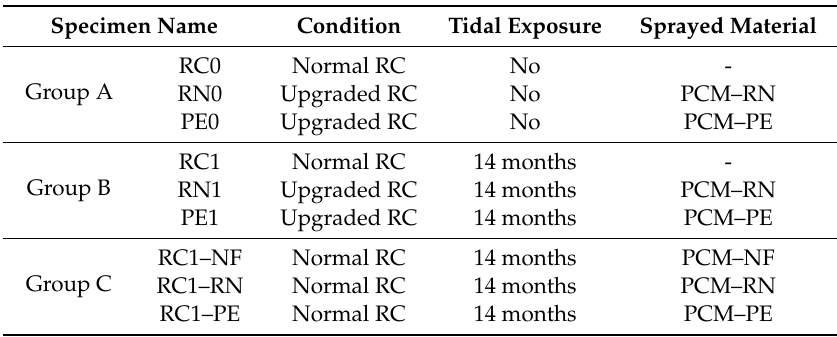
Table 2. Name and conditions of the tested RC beams.